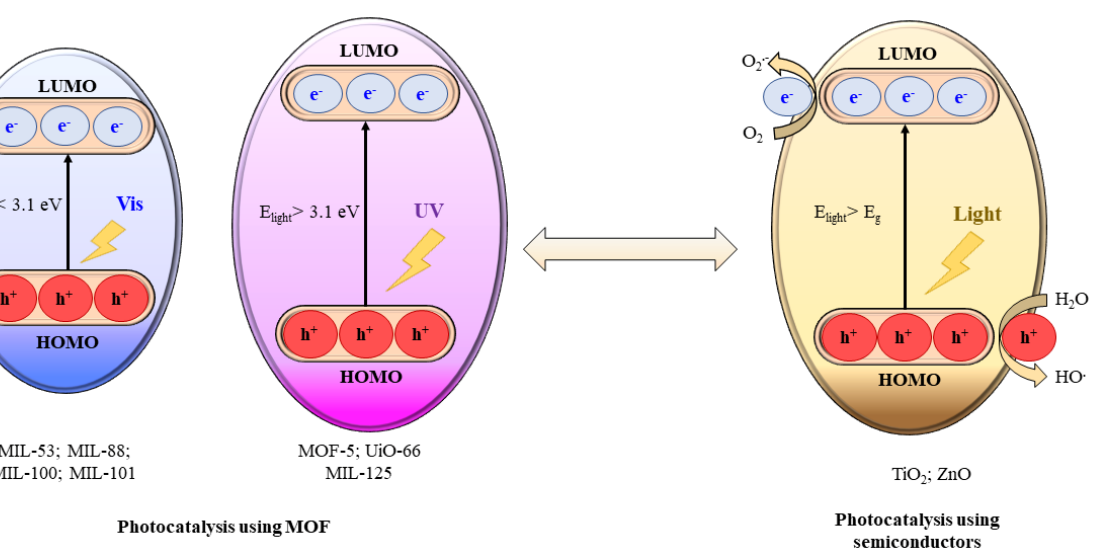
Figure 6. Mechanism of MOF photocatalysis vs. semiconductor photocatalysis. Comparison of band gaps and light source (UV or visible light) between representative MOFs [69].